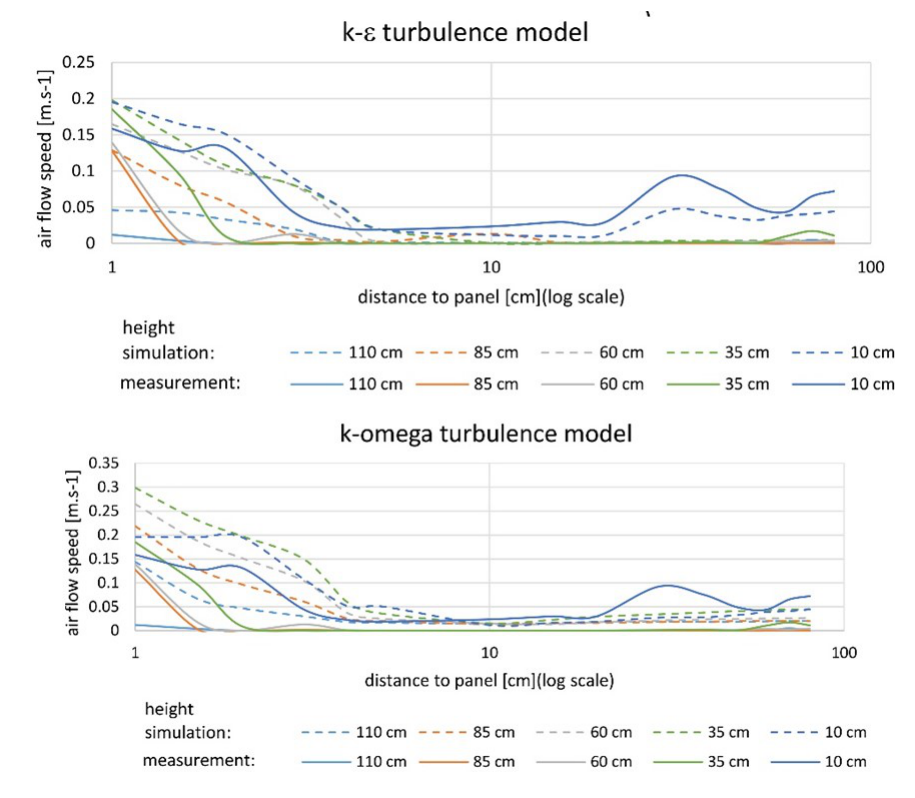
Figure 3. Velocity as a function of distance from the panel for two different turbulence models.